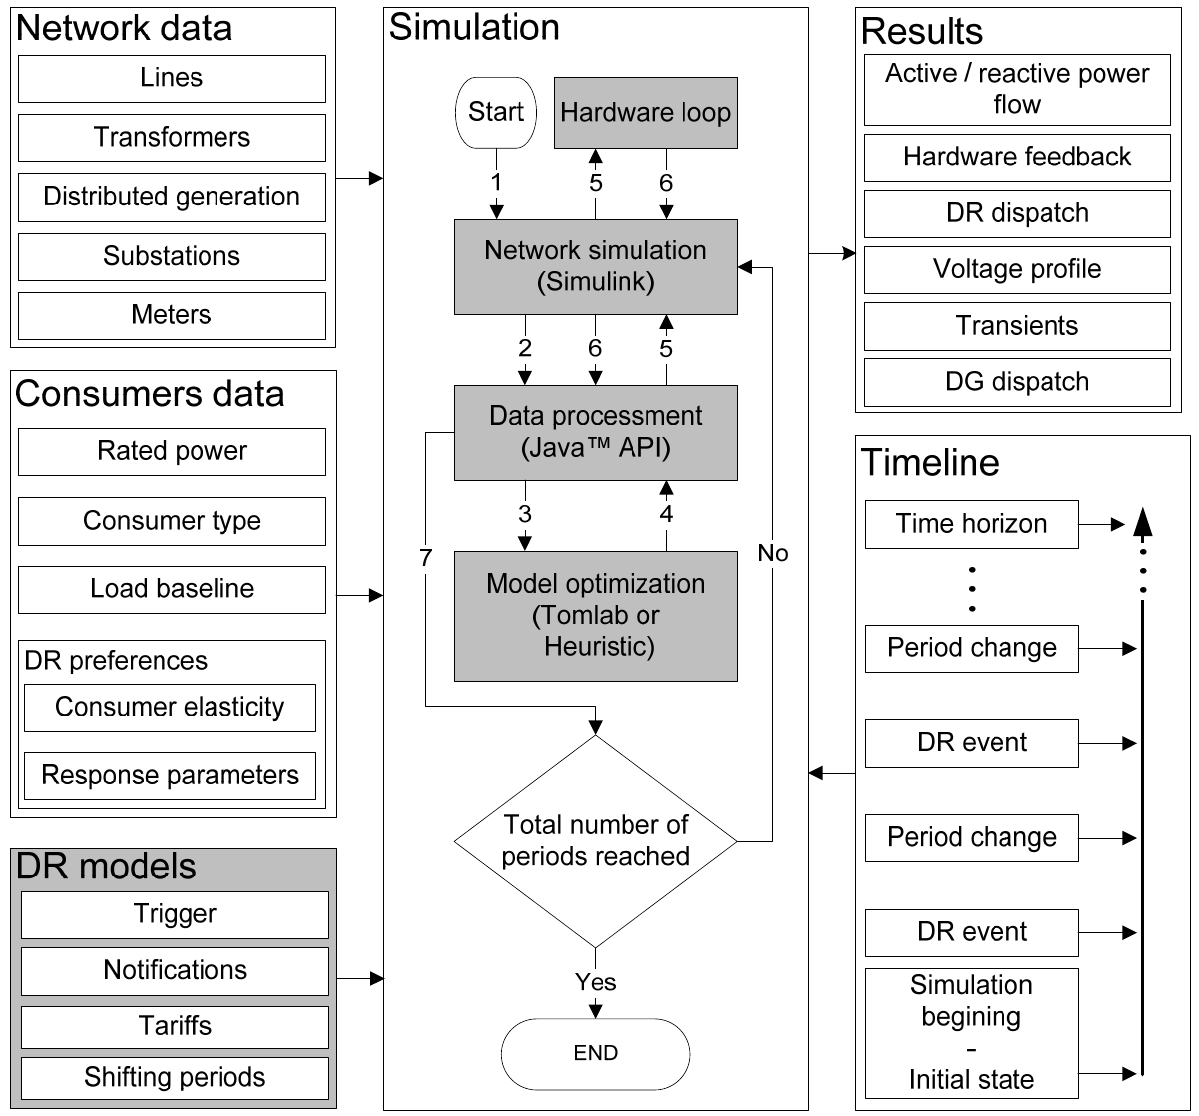
Figure 2. SPIDER simulation